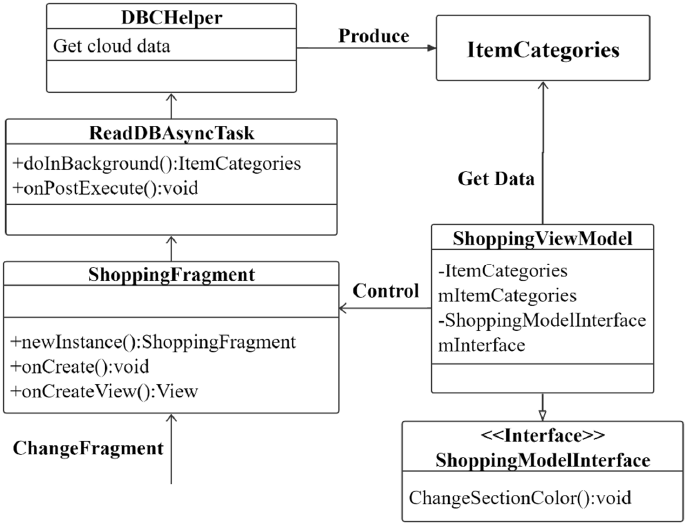
Figure 21. Obtain shopping cart classification information and shopping class formation process.